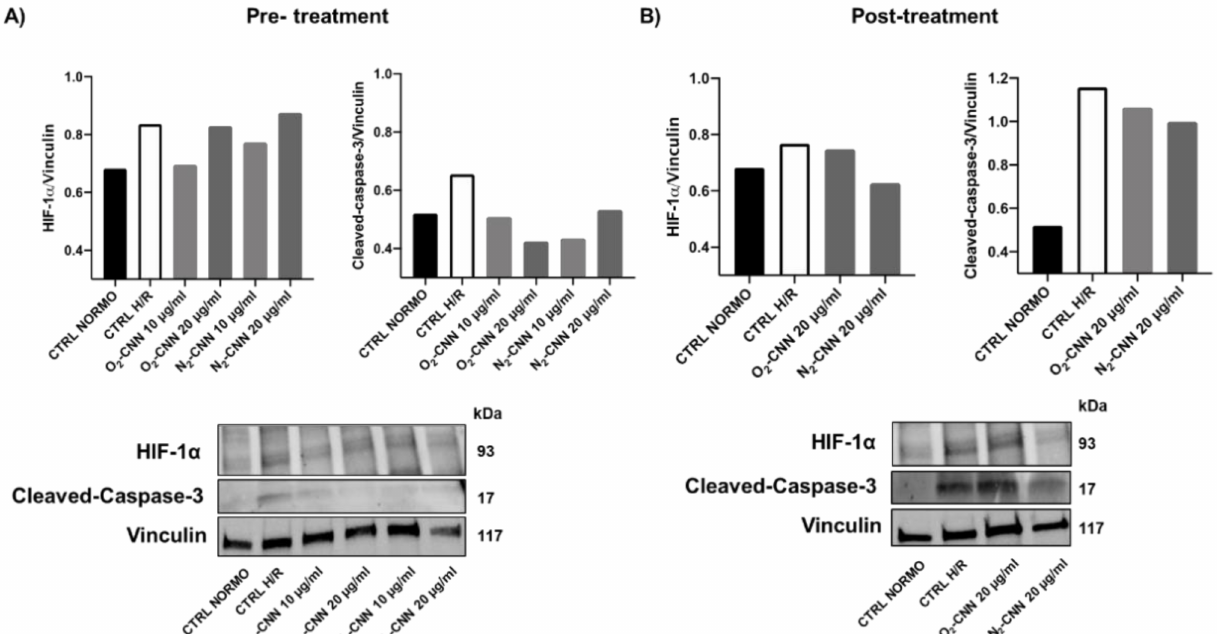
Figure 8. O 2 and N 2 -CNN pre-treated H9c2 in H/R conditions. ( A ): O 2 and N 2 -CNN post-treated H9c2 in H/R conditions. ( B ): Densitometric data and representative Western blots of HIF-1 α , cleaved caspase-3, and vinculin (loading